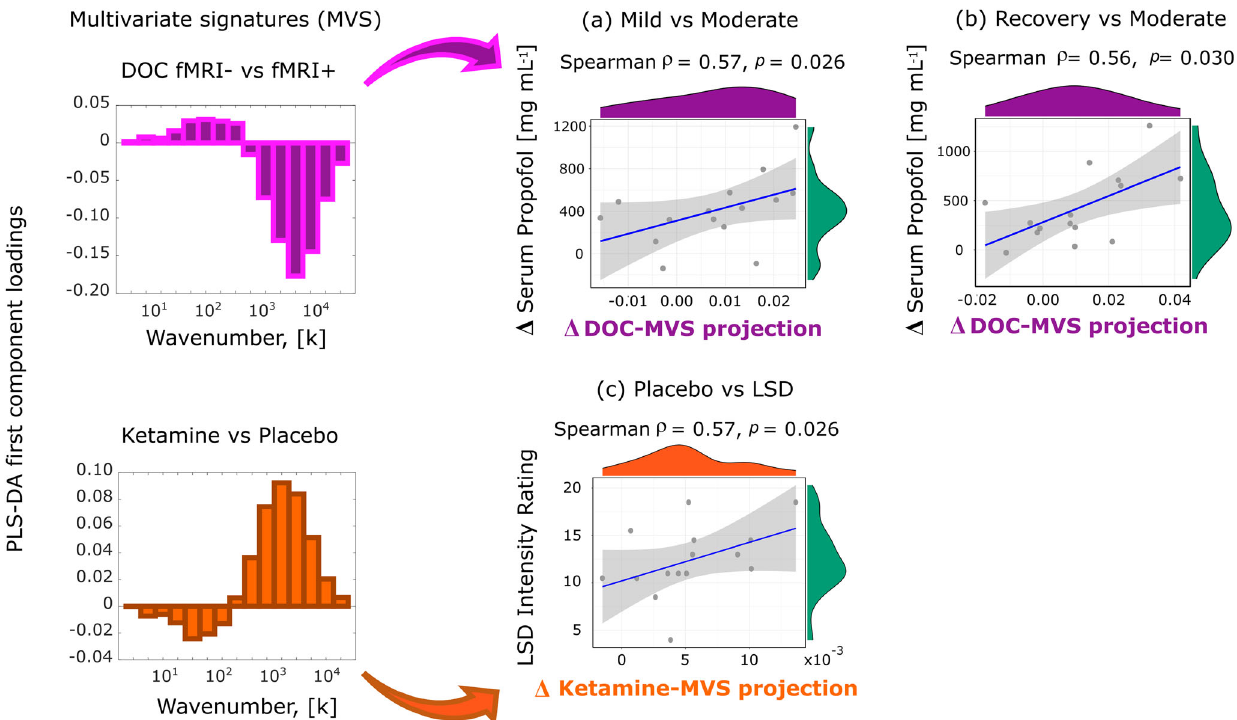
Fig. 4 Neurobiological and subjective relevance of connectome harmonic signatures across states of consciousness. Each scatterplot displays individual scores (serum propofol change or subjective intensity) versus the drug-induced change in alignment (dot product) between that subject ’ s spectrum of connectome harmonic energy, and the multivariate energy signature (MVS). a Change in energy projection onto the DOC energy signature between mild and moderate anaesthesia (moderate minus mild), versus the change of propofol levels in volunteers ’ blood serum ( n = 15 subjects). b Change in energy projection onto the DOC energy signature between moderate anaesthesia and recovery (moderate minus recovery), versus the change of propofol levels in volunteers ’ blood serum ( n = 15 subjects). c Change in energy projection onto the ketamine energy signature between placebo and LSD (LSD minus placebo), versus the subjective intensity of the psychedelic experience induced by LSD ( n = 15 subjects). Note that this similarity between similar subjective states of consciousness induced by different means is not brought about by generic confounding effects across the datasets, such as head motion: for both the propofol and LSD datasets, the same MVS projections were not signi fi cantly correlated with differences in head motion, thereby excluding this potential confound (Supplementary Fig. 8). Shading indicates 95% con fi dence interval. Source data are provided in Supplementary Data